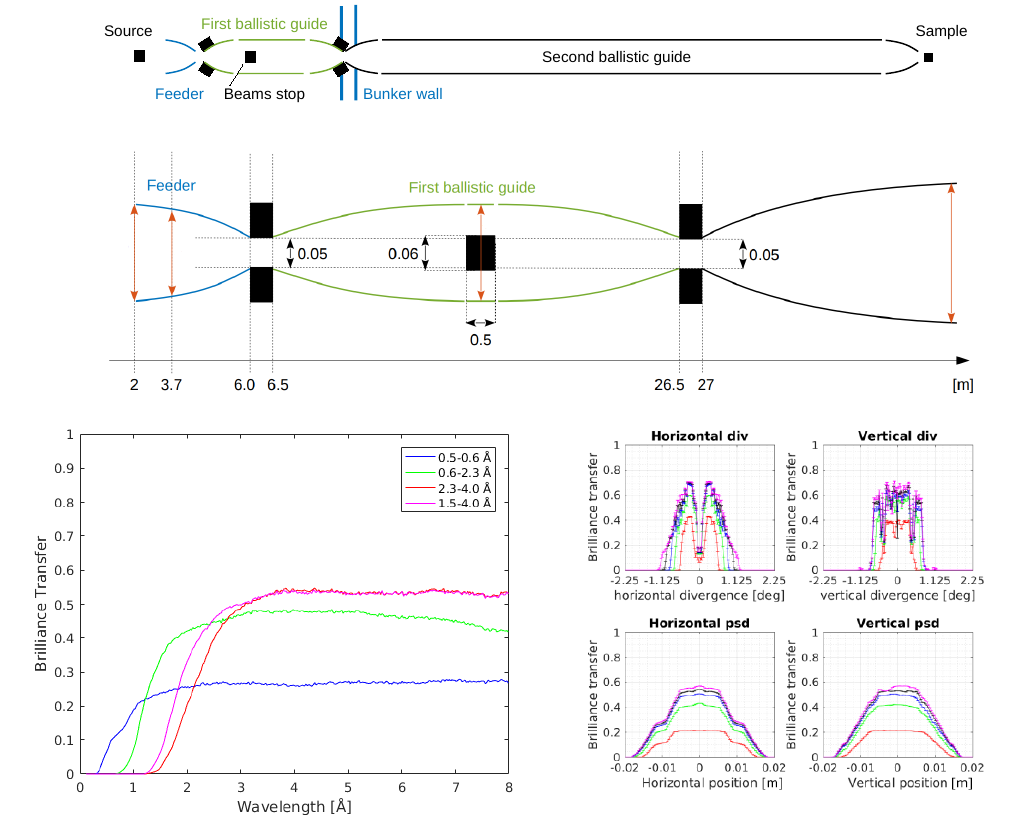
Figure 4. Beamstop guide. Performance of coating-optimized beamstop guides. Top: Schematic drawing of the beamstop guide: the double-pinhole guide, where the direct line-of-sight from the moderator is broken by a beam stop. Middle: the beamstop guide seen from the side. The black numbers indicate the fixed parameters and the red arrows indicate the optimized parameters. The figures are not to scale. The bottom panels show the performance of coating-optimized beamstop guides. Bottom left: Simulated values of BT ( λ ) as a function of neutron wavelength optimized for coating value and geometry for the wavelength bands WB1 (blue), WB2 (green), WB3a (red), and WB3b (purple), using a pinhole size with a height × width = 5 × 3 cm 2 . Bottom right: Integrated BT of the beamstop guide, optimized for WB3b, 1.5–4.0 Å. The panels show the BT as a function of horizontal/vertical position and divergence for different wavelengths marked by colors. (red: 1.5 Å, green: 2.1 Å, blue: 2.8 Å, black: 3.4 Å, purple: 4.0